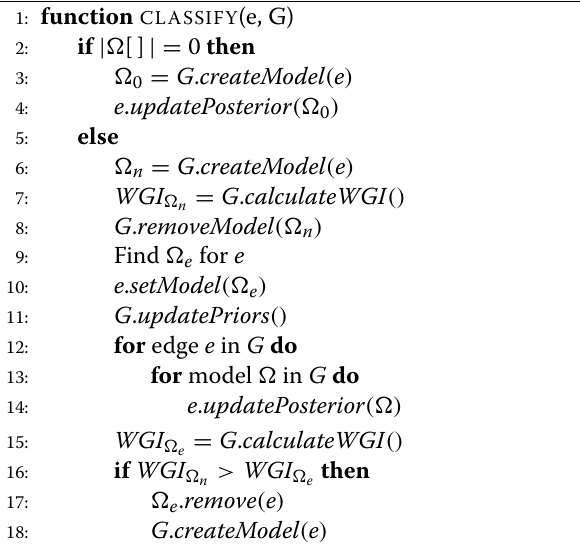
Algorithm 2 Classify an edge e to a new model (cid:2) n or an existing model (cid:2) e with maximum posterior for e in an attack graph G where (cid:2) [ ] represents the list of